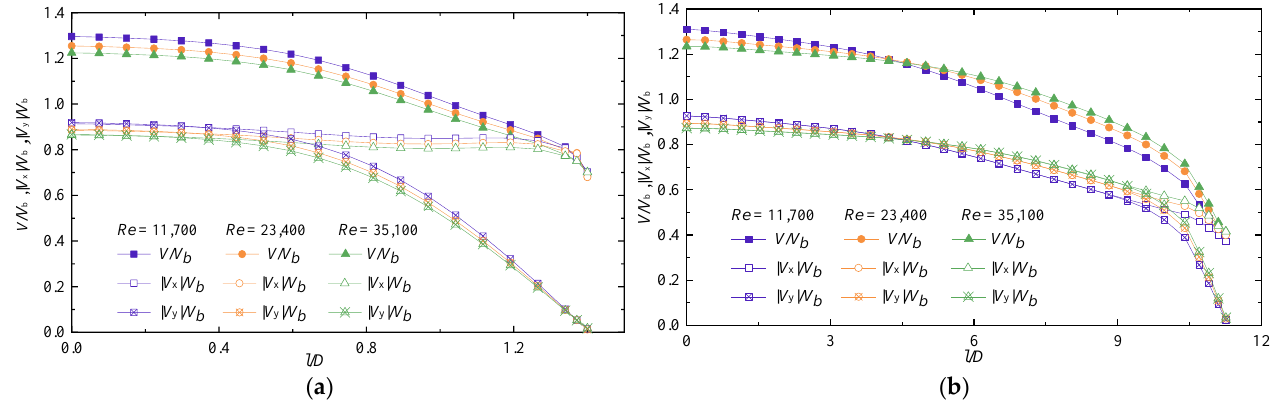
Figure 7. Normalized mean axial ( V/V b ), horizontal ( |V x |/V b ), and vertical ( |V y |/V b ) velocity profiles along the centerline of the impinging jet at various impinging heights: ( a ) H/D = 1; ( b ) H/D = 8. The radial profiles of jet axial velocity V/V b at different impinging heights are shown in Figure 8 ( Re = 35,100). When the impinging height H/D = 1, the velocity profiles are obviously asymmetrical under the influence of the impact wall. The maximum value of V/V b deviated from the axis, and with the increase in l/D , it decreases rapidly at first and